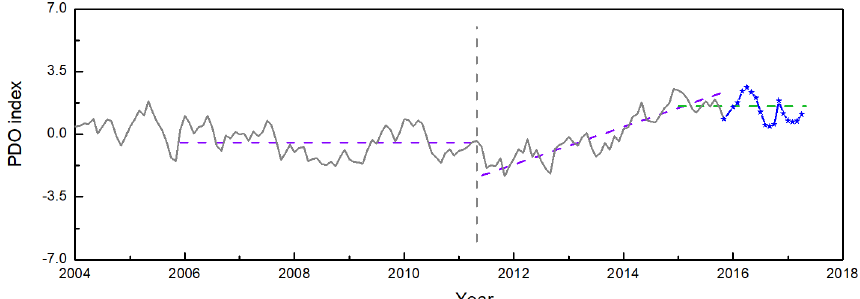
Figure 11. Prediction of the PDO index. The gray line represents the PDO index before 2015, the blue line represents the PDO index after 2015, the gray dashed line represents the start moment and end moment, the purple dashed lines represent the initial state and the linear trend line and the green line represents the prediction end